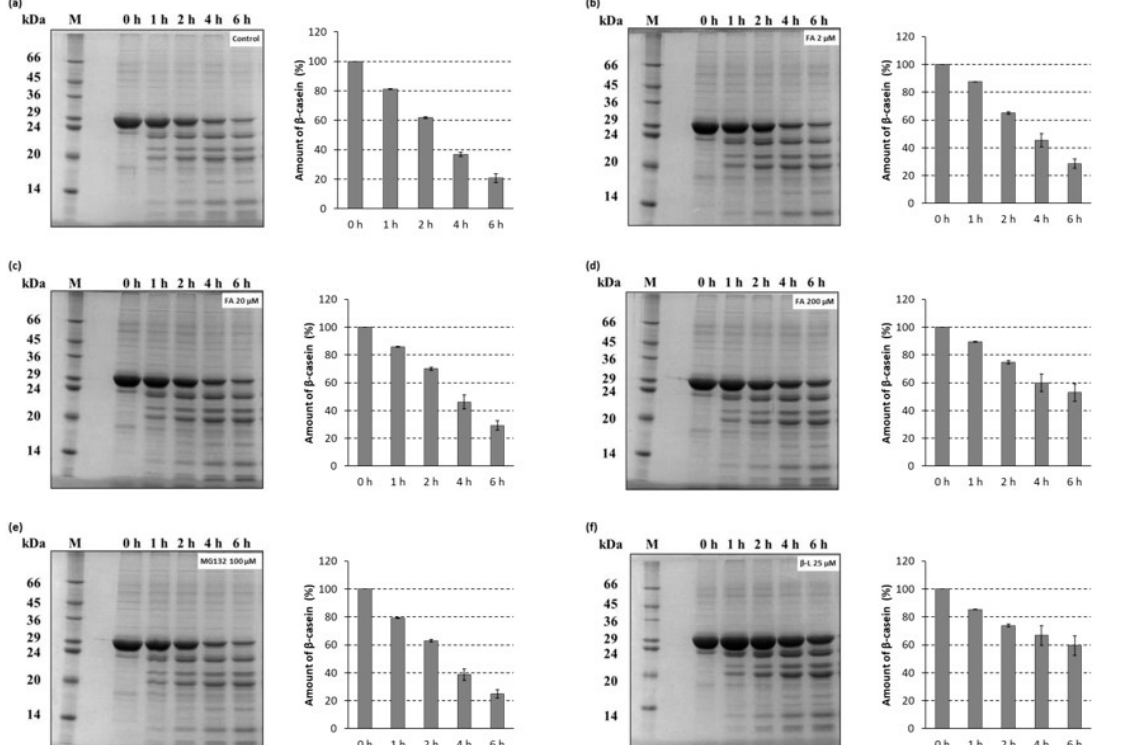
Figure 5. Time course of the 26S fungal proteasome catalyzed β -casein degradation. Proteolysis reaction mixtures containing the 26S proteasomes isolated from T. versicolor were preincubated with: ( a ) DMSO as solvent control or ( b – d ) ferulic acid (FA) at various concentrations for 30 min before the addition of a model protein substrate ( β -casein). Proteasome inhibitors: ( e ) MG132 and ( f ) clasto-lactacystin β -lactone ( β -L) were used as comparison to ferulic acid. At the indicated time points reaction aliquots were added to SDS sample buffer and analyzed by SDS-PAGE (12% polyacrylamide gel, 29:1 acrylamide:bisacrylamide) followed by microwave-assisted Coomassie Brilliant Blue R-250 staining. The data represent results from one of three independent experiments with similar results. Quantification plots of the PAGE gels illustrate the amount of β -casein.